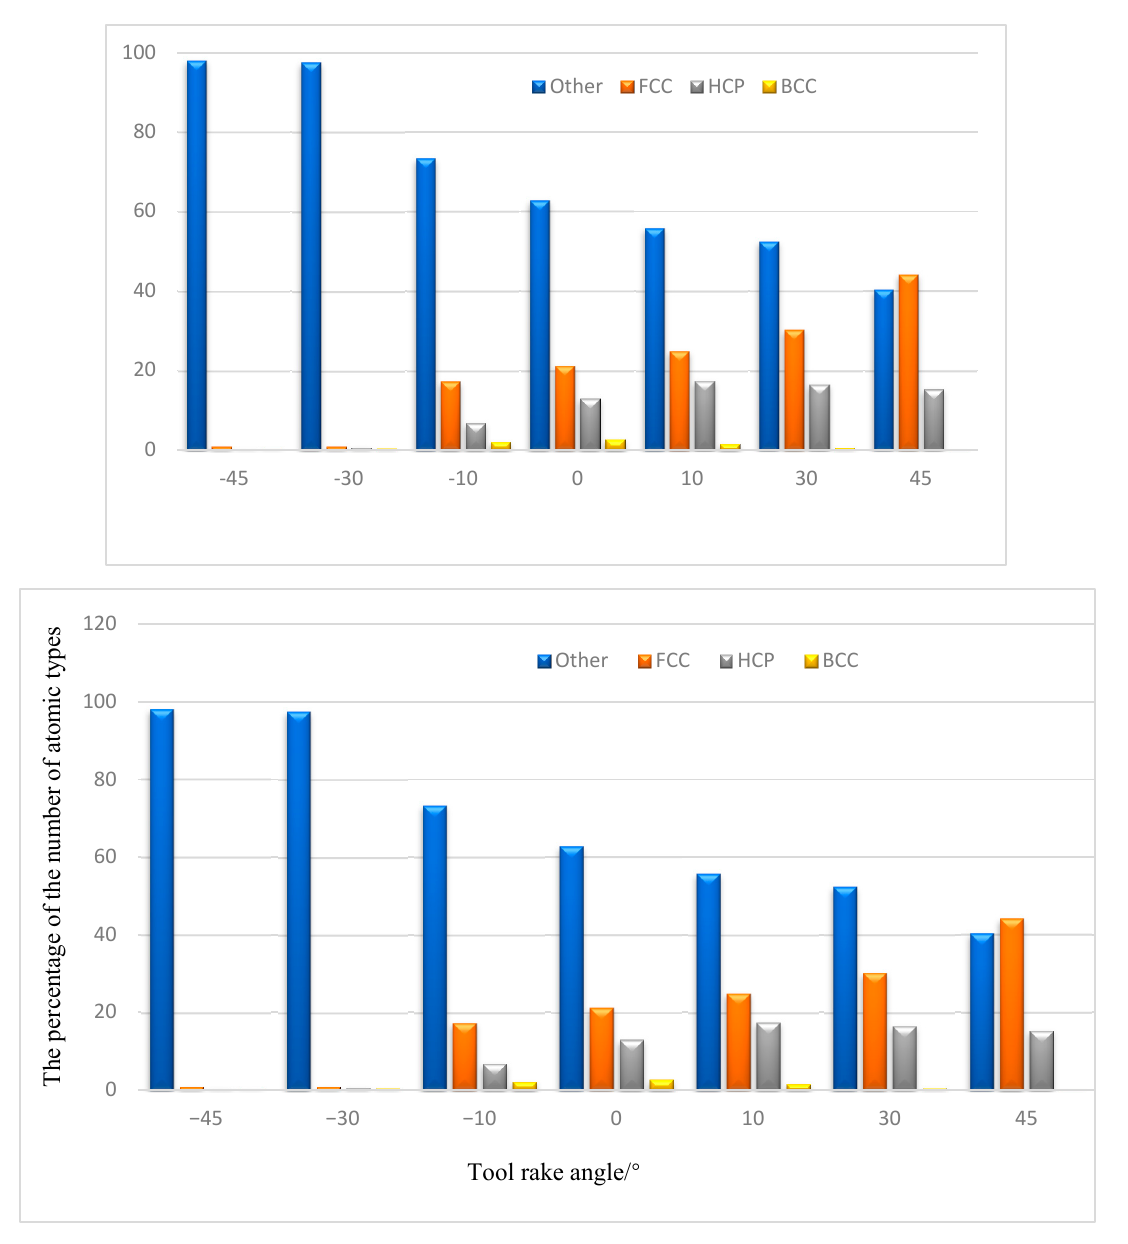
Figure 9. Percentage of different crystal structures in the wear chips.